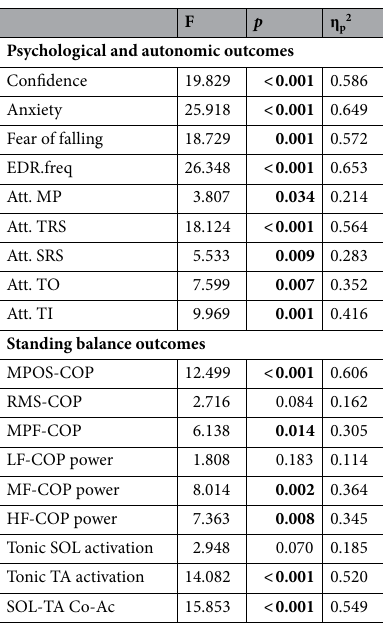
(n=15)Psychological and autonomic outcomes for “Adaptors” (n=15)